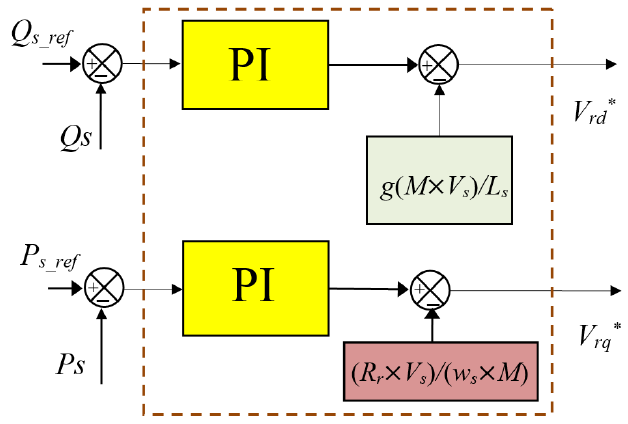
Figure 8. Structure of the traditional DVC method.